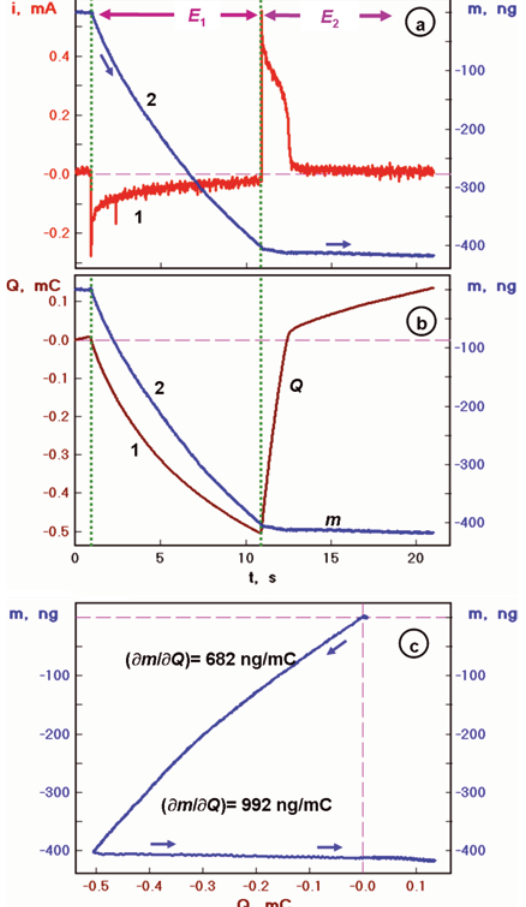
Figure 3. Electroreduction of a WO film on Au piezoelectrode in 3-x 100 mM TEAC: (a) current (1) and apparent mass change = -0.5 V, E = +0.5 V; (2) responses to potential steps: E 1 2 (b) m-Q